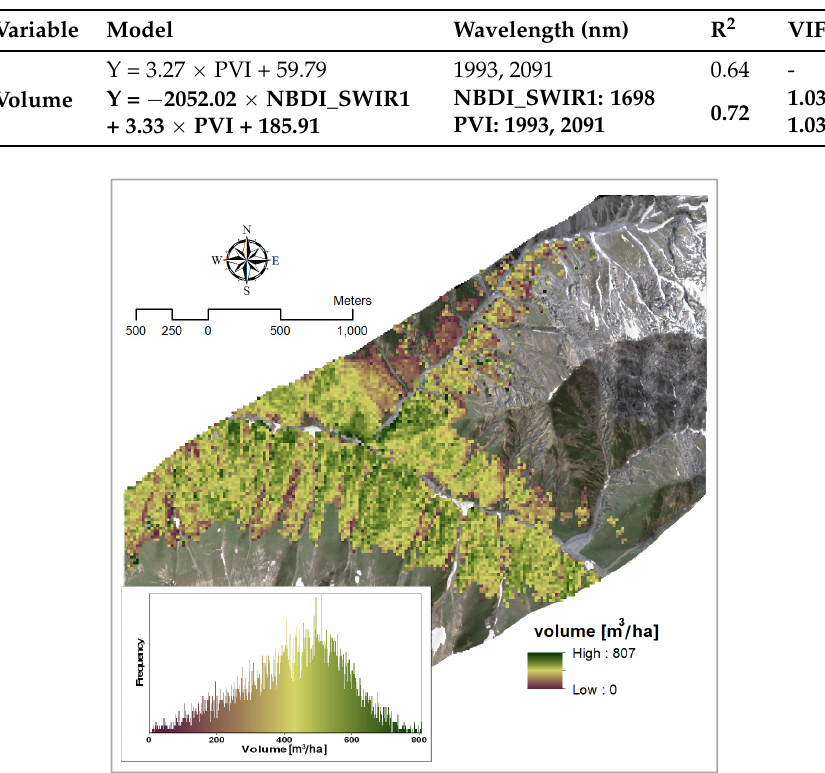
Figure 6. Map and frequency distribution of estimated forest volume in Val Trupchun; an APEX true color composite is used as background.